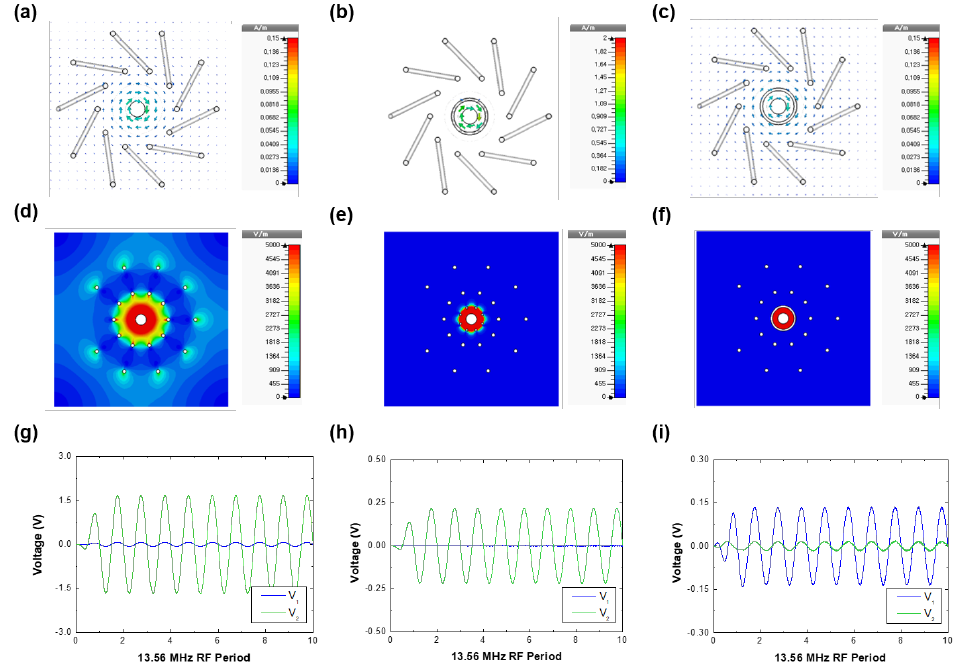
Figure 3. Magnetic field vectors (cid:126) B = (cid:126) B x + (cid:126) B y + (cid:126) B z (top row), magnitude of electric fields (cid:113) | E | = E 2 x + E 2 y + E 2 z (middle row), and voltage waveforms of V 1 and V 2 (bottom row) for ( a , d , g ) capacitive and inductive coupling, ( b , e , h ) capacitive coupling only, and ( c , f , i ) inductive coupling only. In the figure, V 1 means the voltage difference between the ends of the floating toroidal coil, and V 2 is the voltage difference between the center of the coil and the grounded